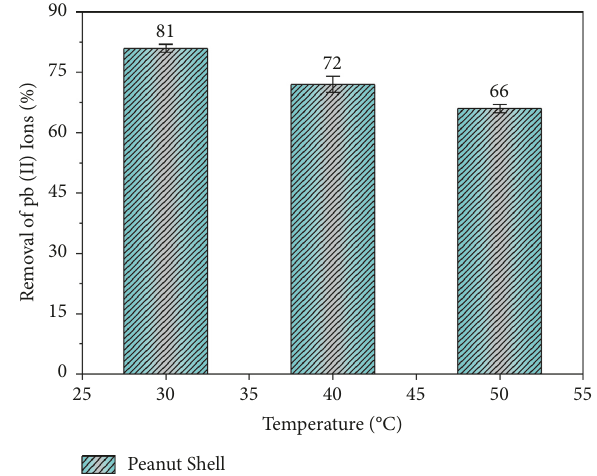
Figure 2: FTIR Spectrum for peanut shell. Table 2: BET